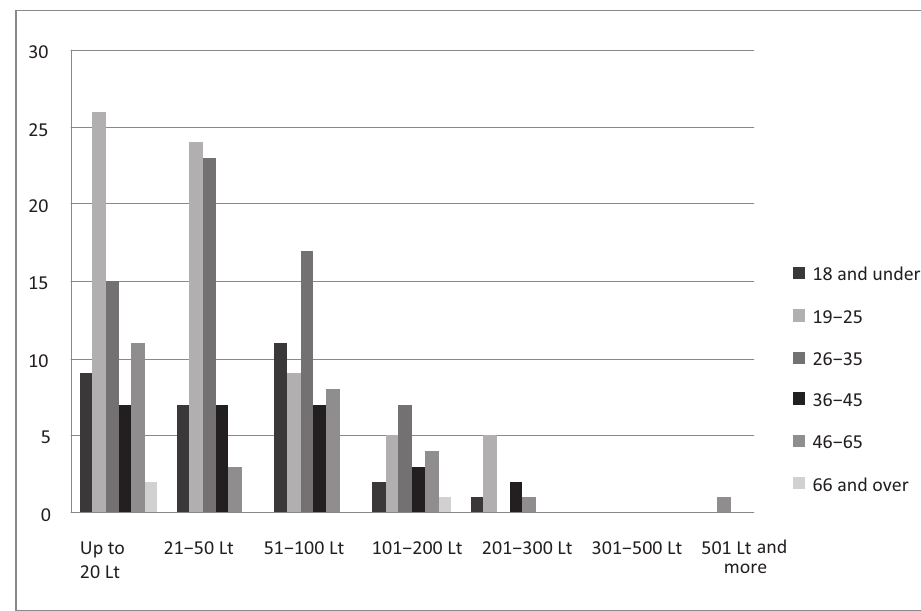
Fig. 20. Correlation between expenses during the festival period and